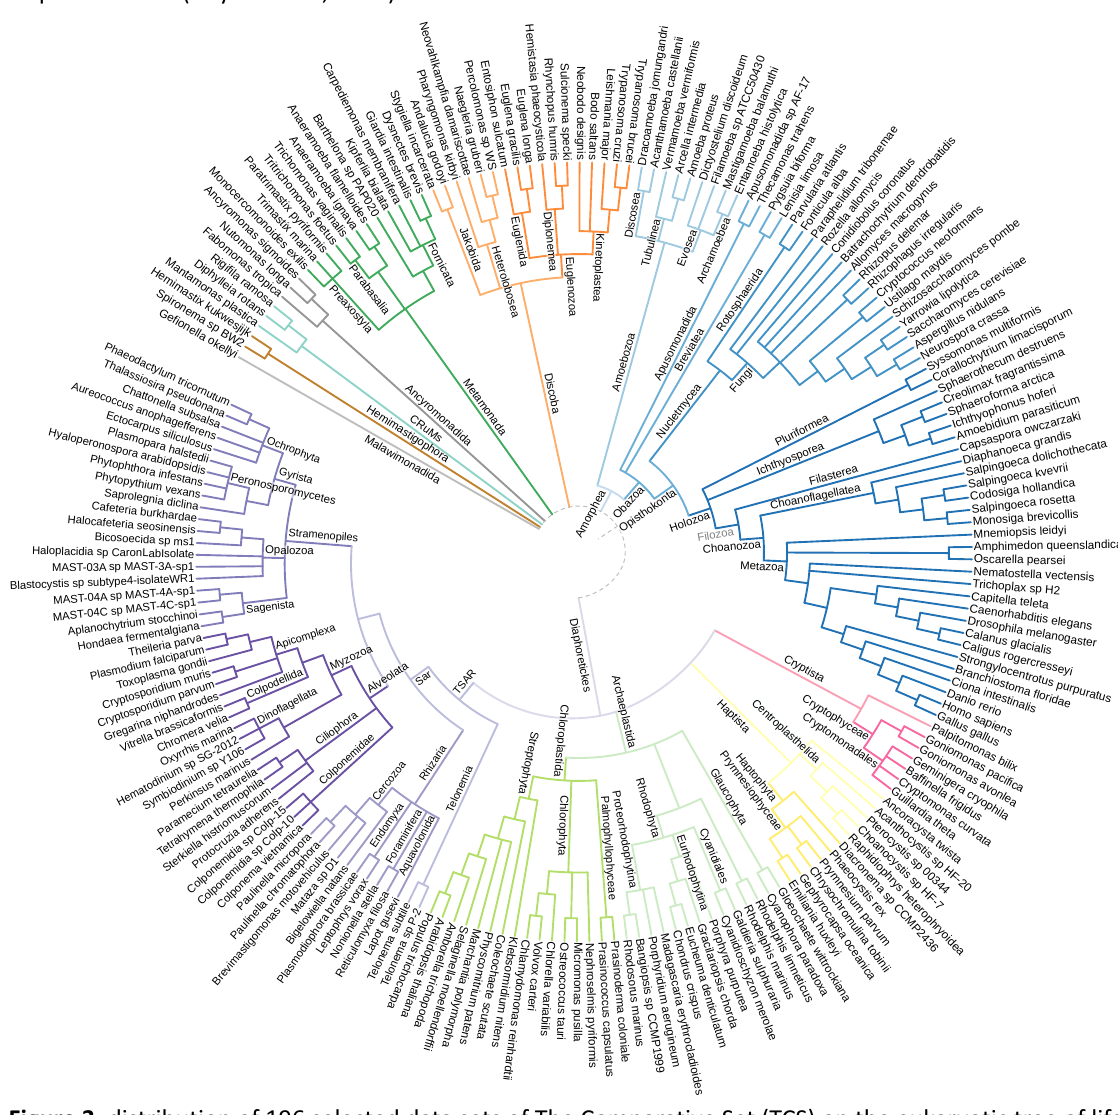
Figure 3 : distribution of 196 selected data sets of The Comparative Set (TCS) on the eukaryotic tree of life, with relationships based on the UniEuk taxonomy (Berney et al., 2017; Adl et al., 2019). The position of the eukaryotic root, indicated with a dashed line, is currently unresolved. Group names shown in gray are not officially recognized. The figure was created with iTOL (Letunic & Bork,